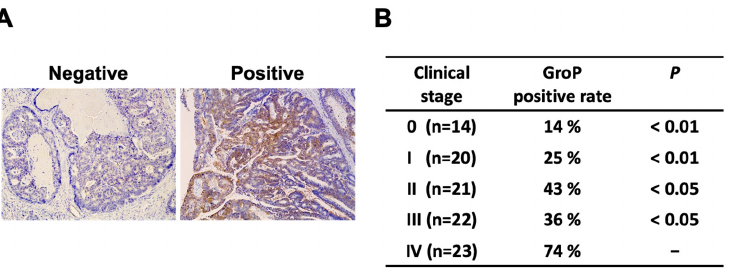
Figure 1. Immunohistochemical analysis for glycerol phosphate (GroP) modification in human colorectal cancer tissues. ( A ) Representative images of staining with DG2. The left and right panels represent negative and positive DG2 staining, respectively, in human colorectal cancer tissues (×100). ( B ) GroP expression according to disease stage. The p -value in each stage was calculated by comparison with the positive rate in stage IV.